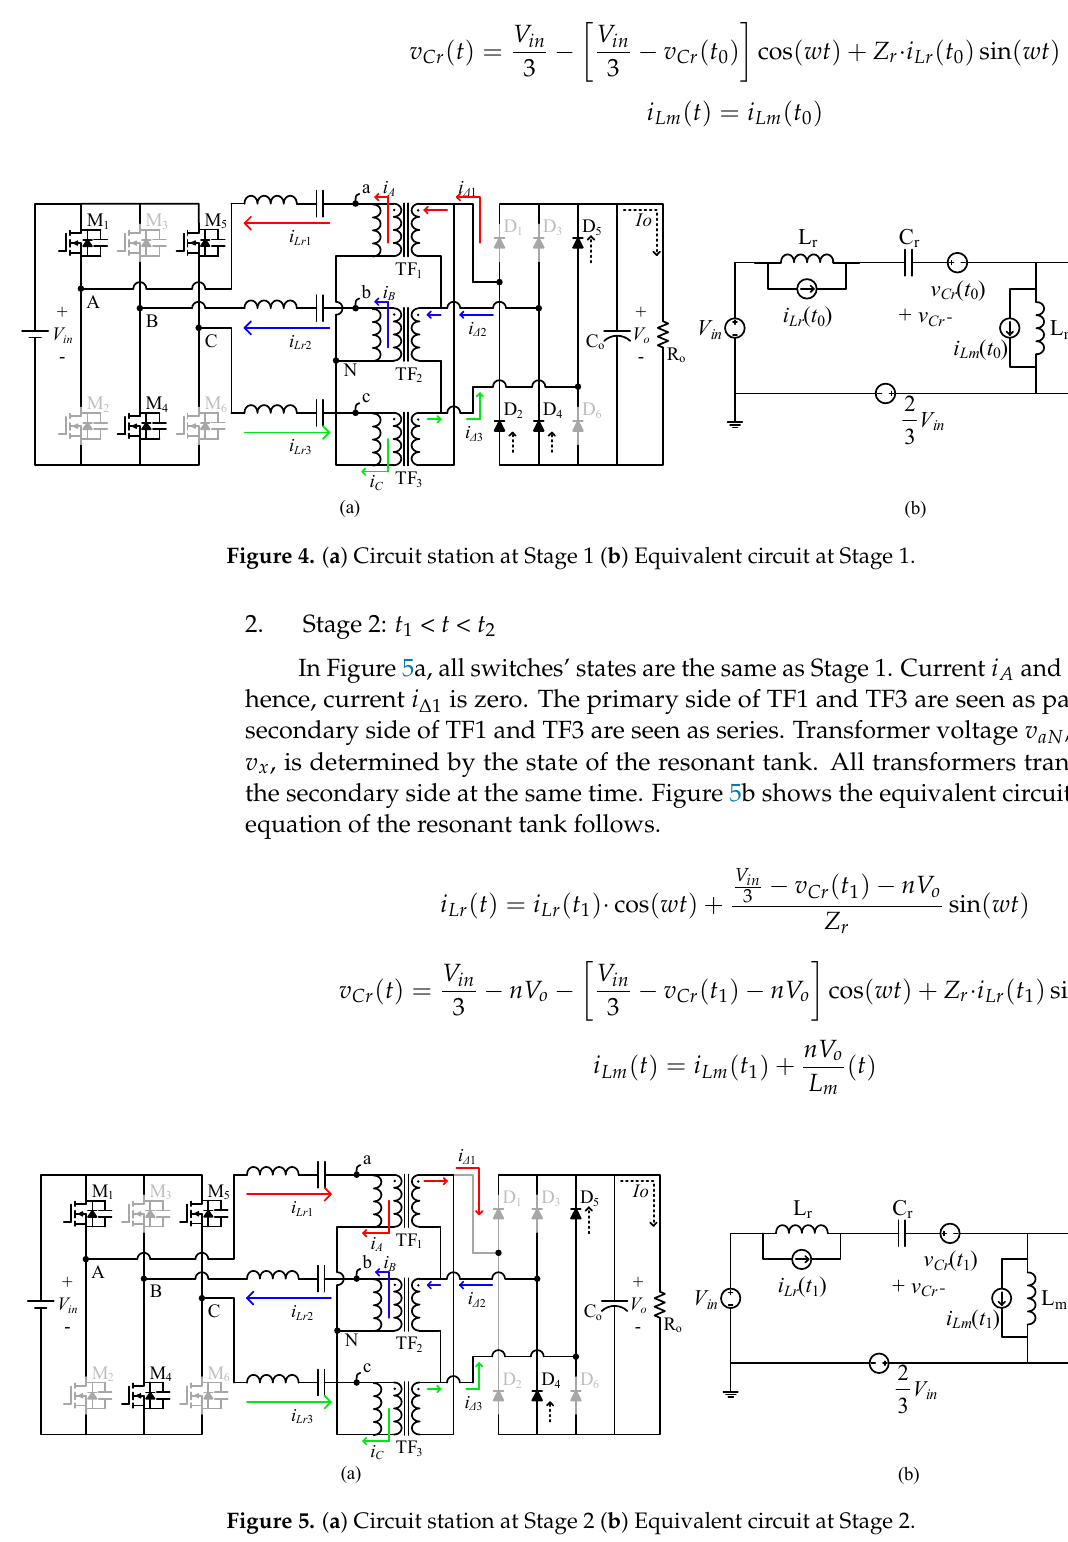
Figure 5. ( a ) Circuit station at Stage 2 ( b ) Equivalent circuit at Stage 2.